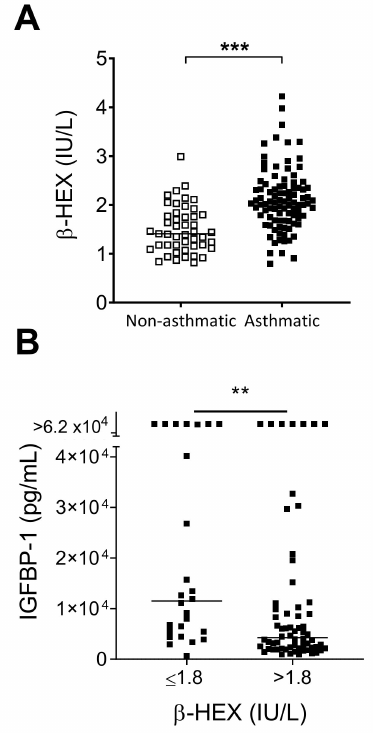
Figure 2. β -hexosaminidase ( β -HEX) in asthmatic patients. ( A ) Asthmatic children had higher levels of β -HEX compared to hospitalized, nonasthmatics. Medians in each group are shown by horizontal lines. Data were analyzed by the Mann-Whitney U test (*** p < 0.001). ( B ) High β -HEX levels associated with low IGFBP-1. Asthmatic patients with > 1.8 IU / L β -HEX exhibited lower levels of IGFBP-1 compared to asthmatic patients with ≤ 1.8 IU / L β -HEX values. Patients in the two groups were compared for high / low IGFBP-1 values (cut-o ff 5000 pg / mL) using the Fisher’s Exact test (** p <